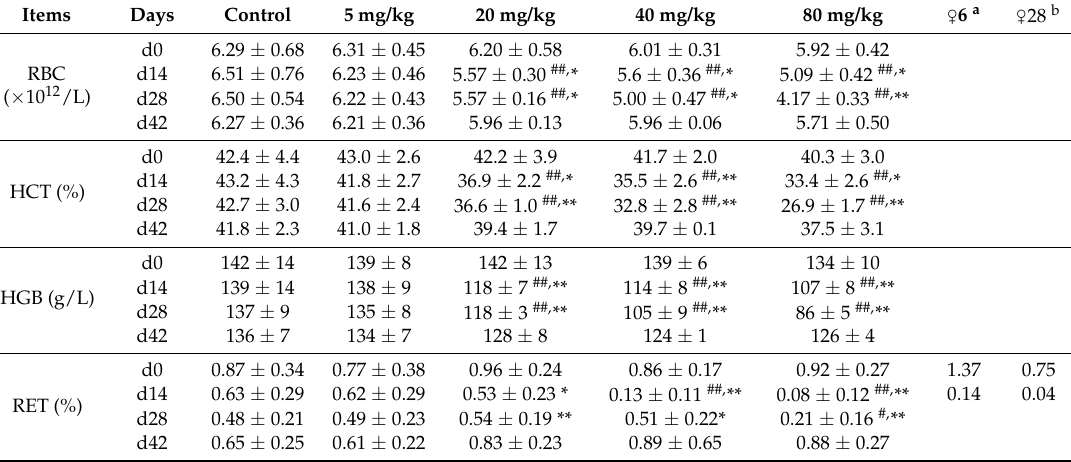
Table 2. Selected hematological parameters induced by HZ1006 in Beagle dogs following repeated dose administration during the study of subchronic toxicity (only significant results are